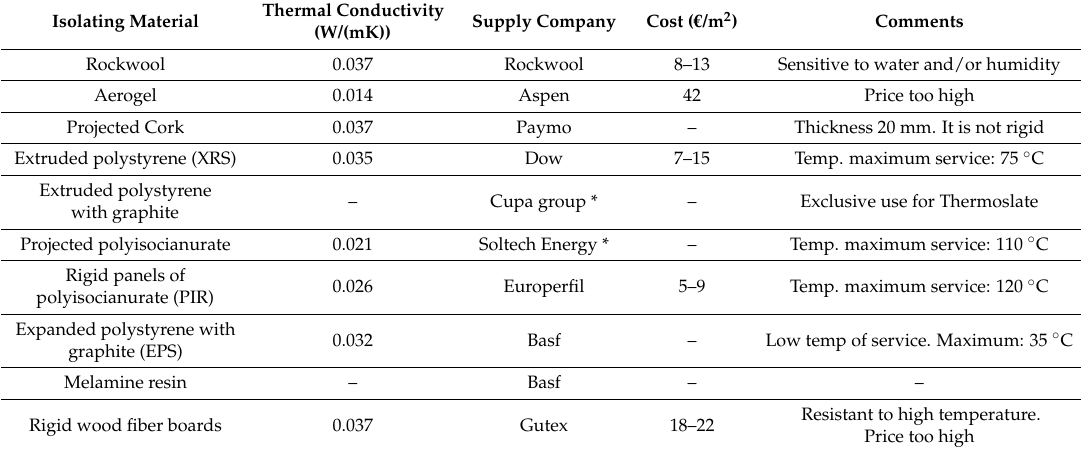
Table 1. Analyzed values of each of the thermal insulators